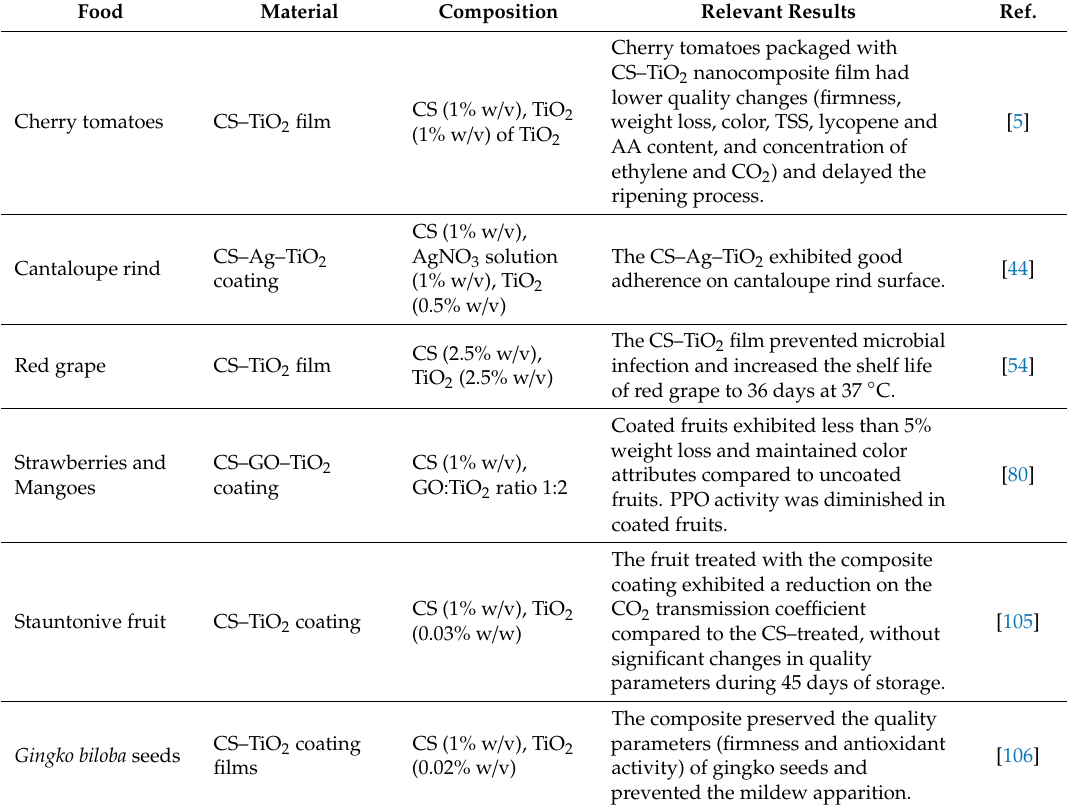
Table 7. Potential food applications of CS–TiO 2